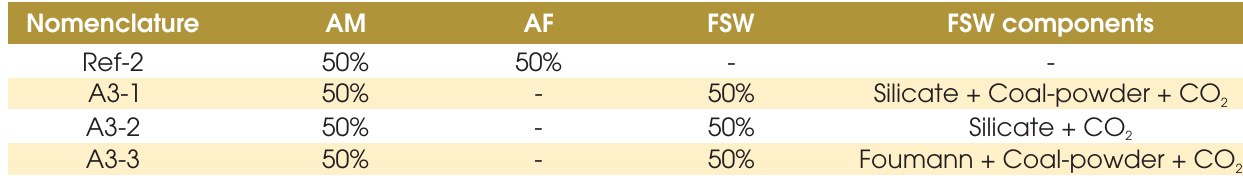
Table 11 – Mortars nomenclature, FSW composition and volumetric